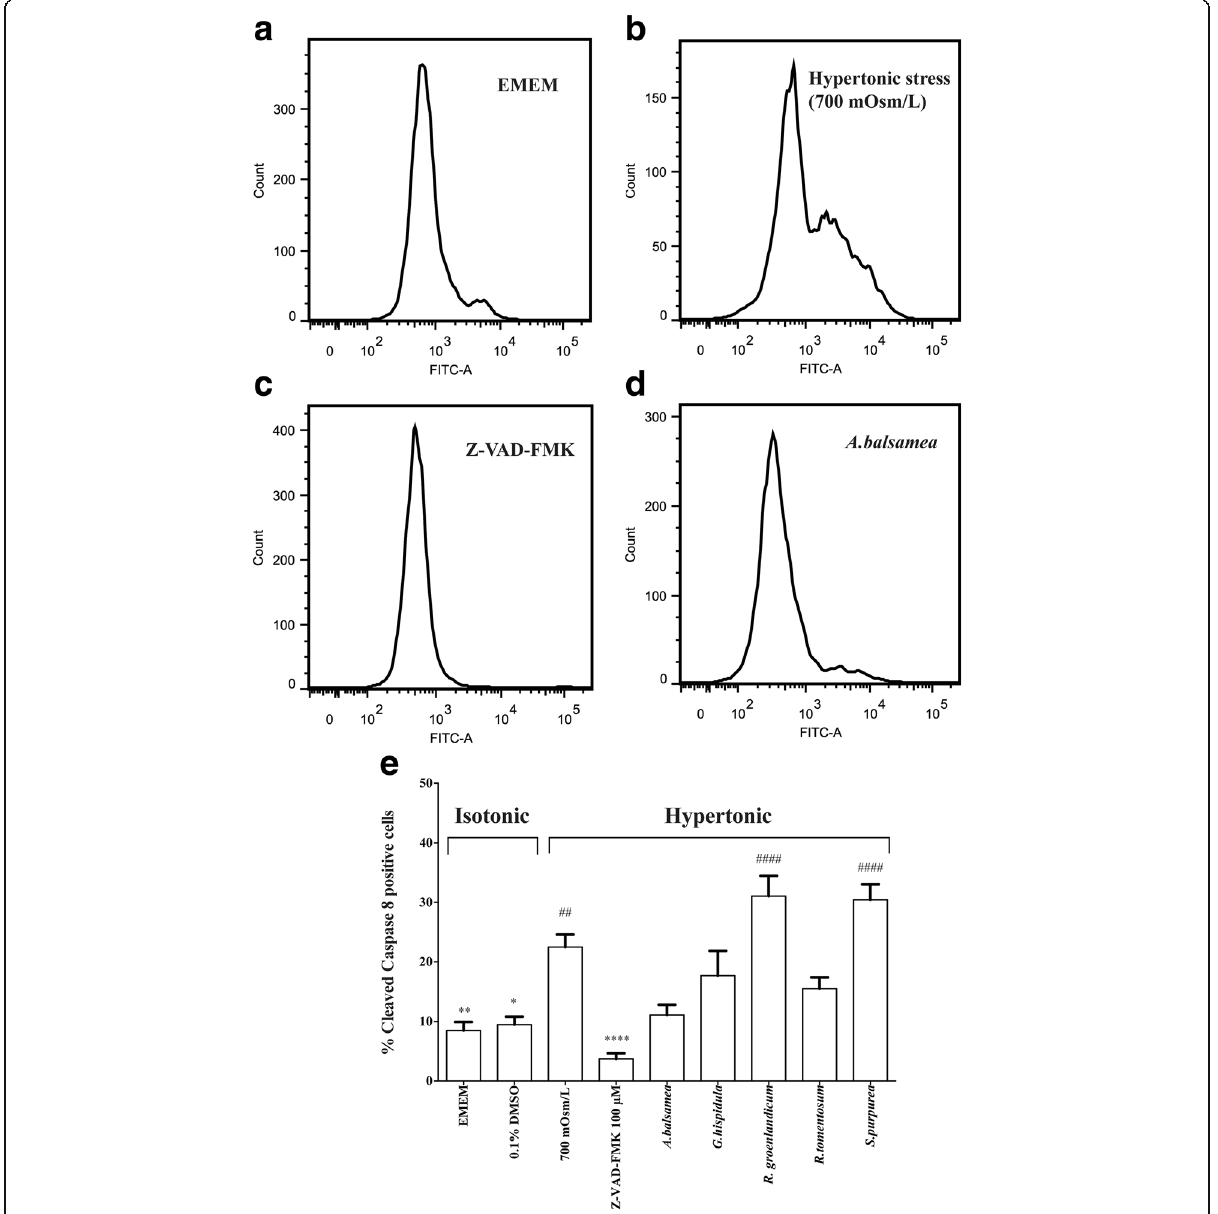
Fig. 3 Cleaved caspase 8 activity. Cleaved caspase 8 activity test was performed 18 h after the treatment with respective plant extracts. a - d Representative pictures of flow cytometry. Ordinate indicates cell count whereas abscissa represents fluorescence signal strength. From left to right, 1st peak indicates procaspase 8 and 2nd peak represents cleaved caspase 8 activity. e Histogram of percent cleaved caspase 8 positive cells. The percent cleaved caspase 8 activity was calculated as the area of 2nd peak/total area × 100. Results were expressed as means ± SEM for